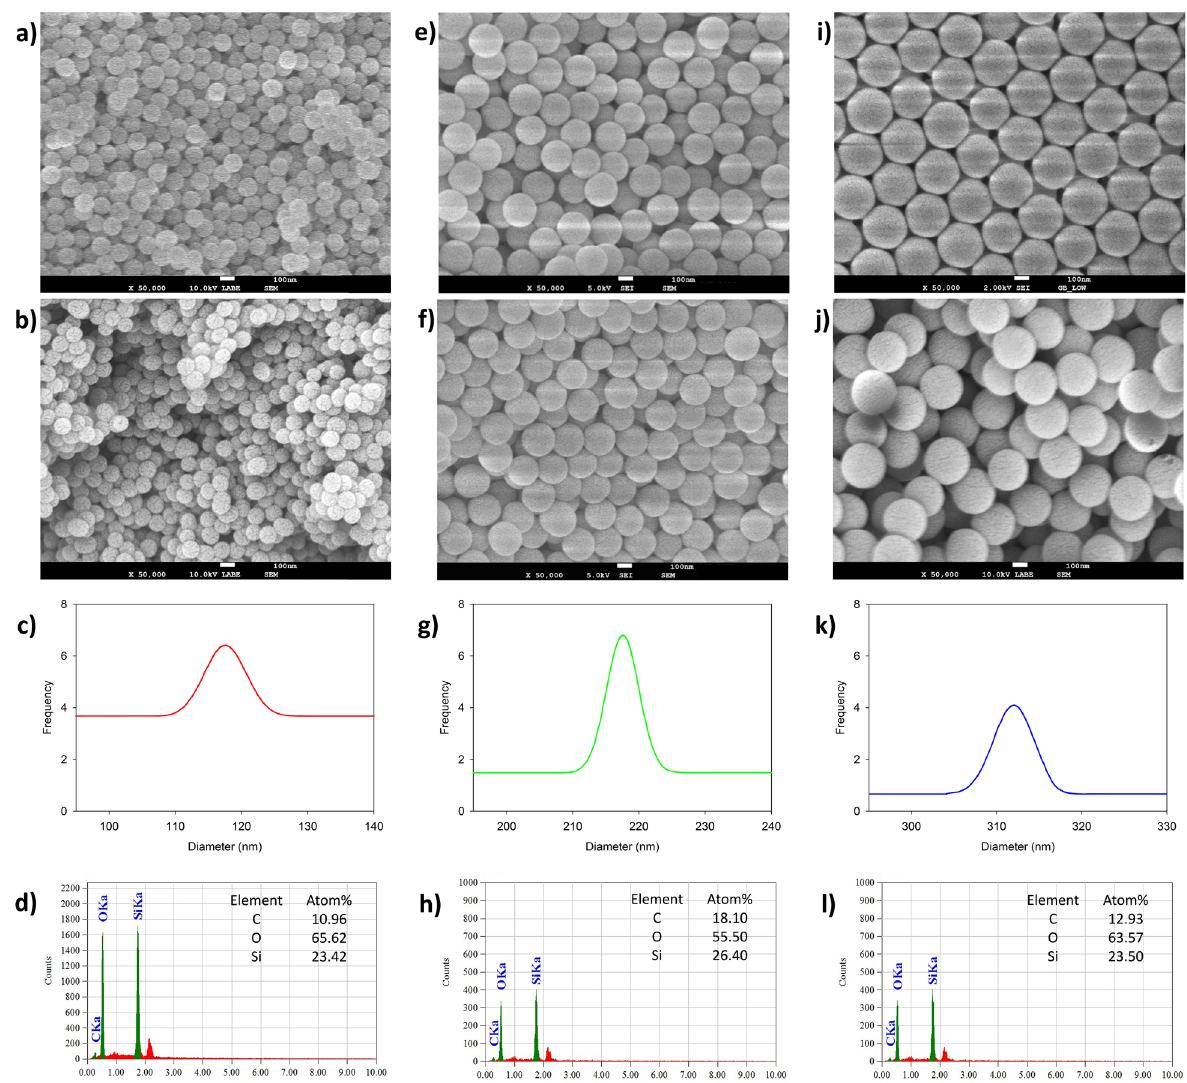
Figure 3. FE-SEM images of SiO 2 , MSiO 2 , particle size distribution curve of MSiO 2 , and EDXS spectra of